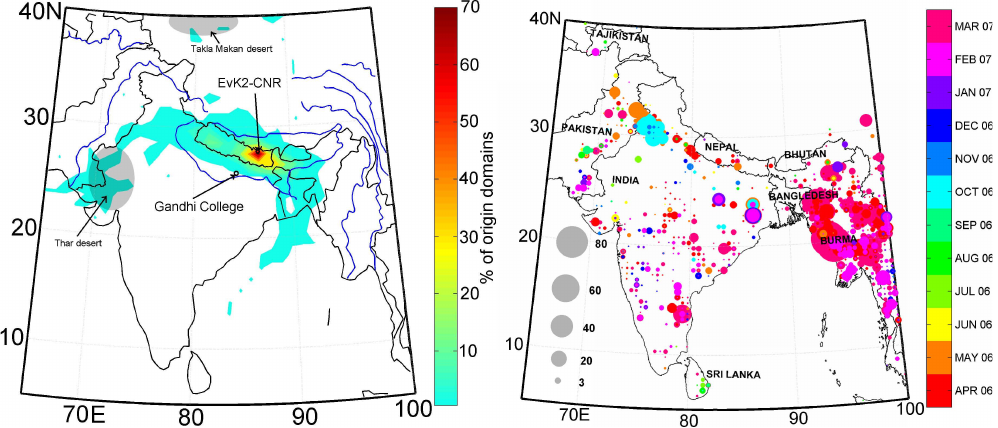
Fig. 1. (a) location of the Ev-K2-CNR (at NCO-P) and Ghandi College (GC) AERONET stations and (colour-coded) PBL transit density of all the backtrajectories ending 600ma.g.l. at NCO-P in the period April 2006–March 2007 (see Sect. 2.2 for details on backtrajectories); (b) : monthly averages of fire counts per 1000km 2 per day, as observed by MODIS Terra. Bullet size identifies the number of fires, colour code the relevant